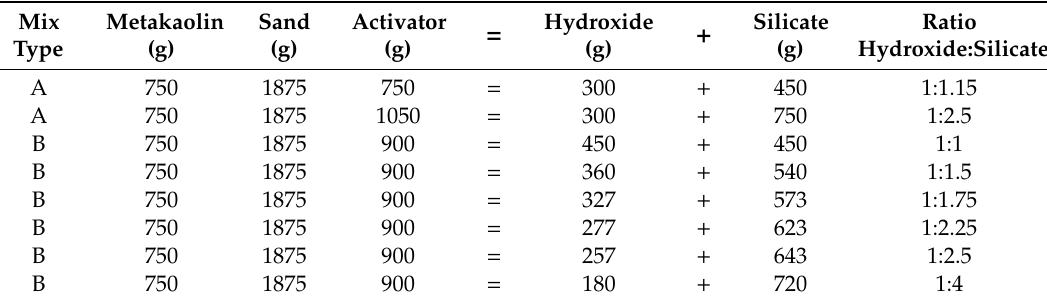
Table 3. Other compositions of the geopolymers.